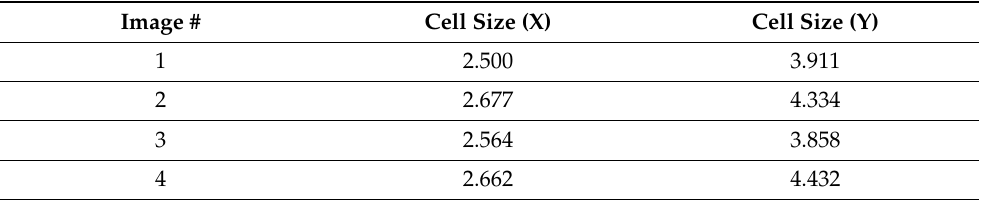
Figure 6. Example of skewed cell sizes after georeferencing. Table 3. Cell size of images after georeferencing. Image No. 1–4 refers to our internal numbering scheme for the individual strips.